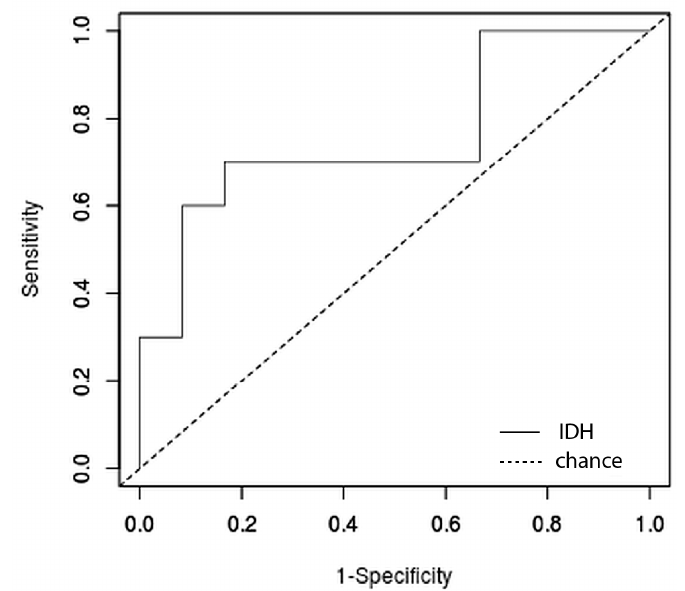
Figure 4. Receiver Operating Characteristic (ROC) curve of the IDH prediction test. IDH, Isocitrate Dehydrogenase.